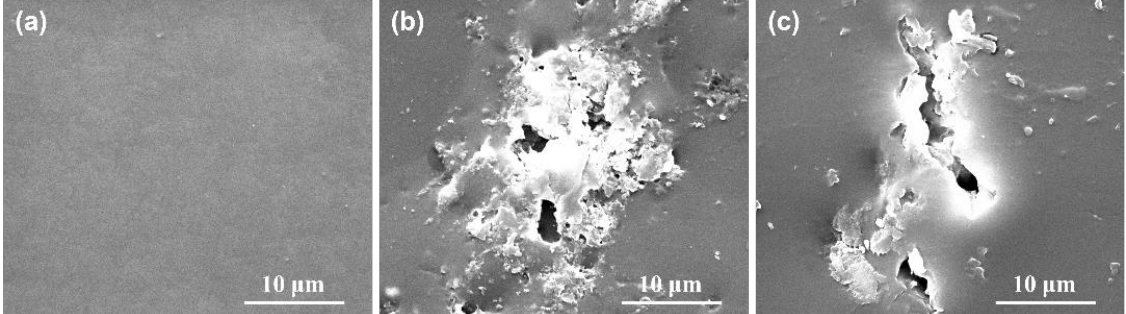
Figure 3. SEM morphologies of the coating surfaces after removing the adherent cells from the inoculated media with ( a ) 100% nutrients, ( b ) 10% nutrients, and ( c ) 0% nutrients.